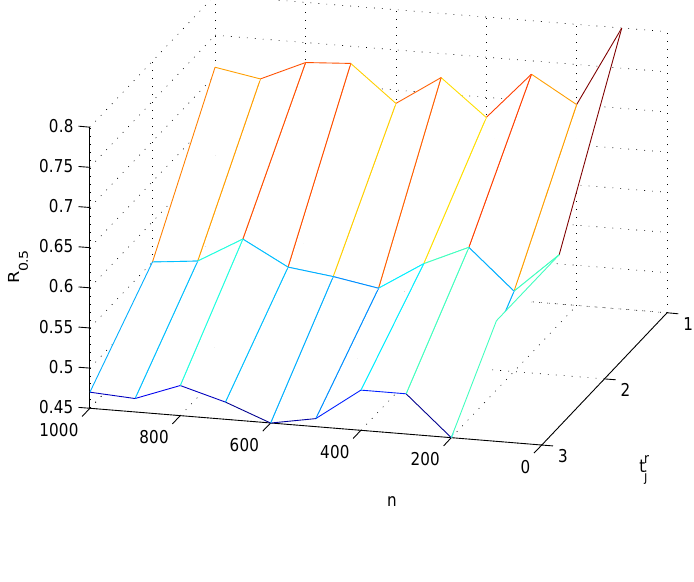
’s of AAD in different settings ( | N 0 . 5